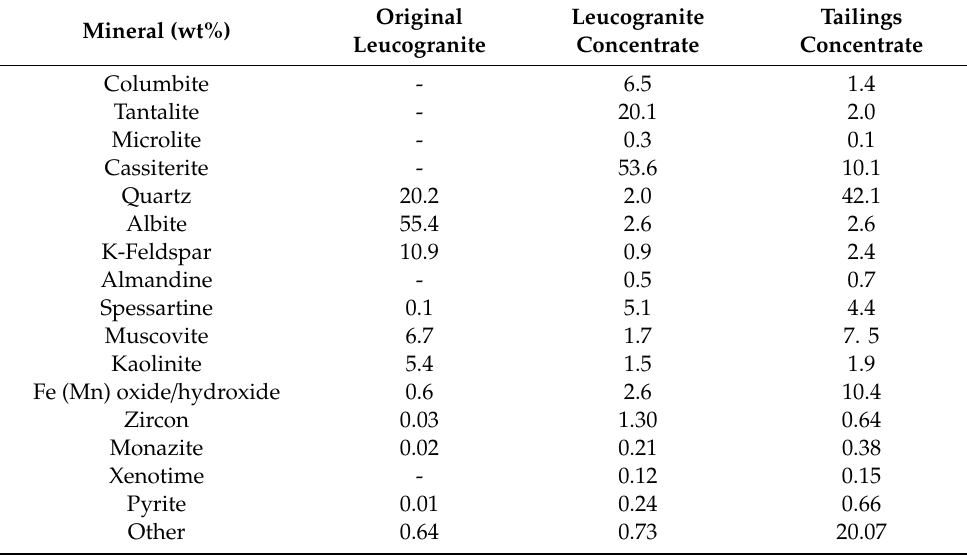
Table 3. Modal mineralogy of the leucogranite from Penouta and concentrates from tailings and